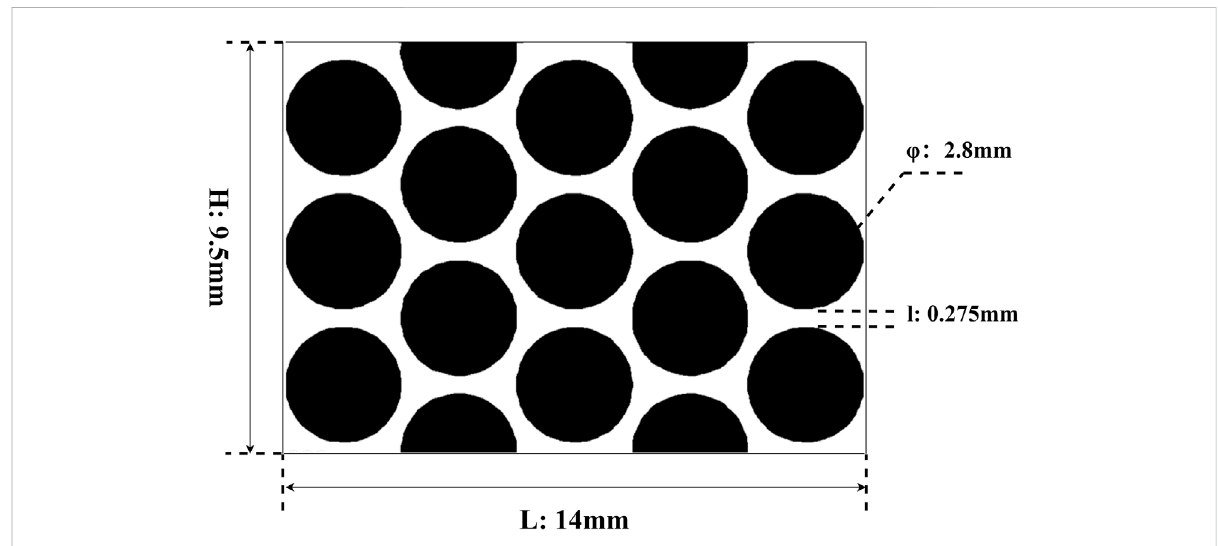
FIGURE 4 Simulation domain: the black represents the solid grain, and the white represents the porous space.